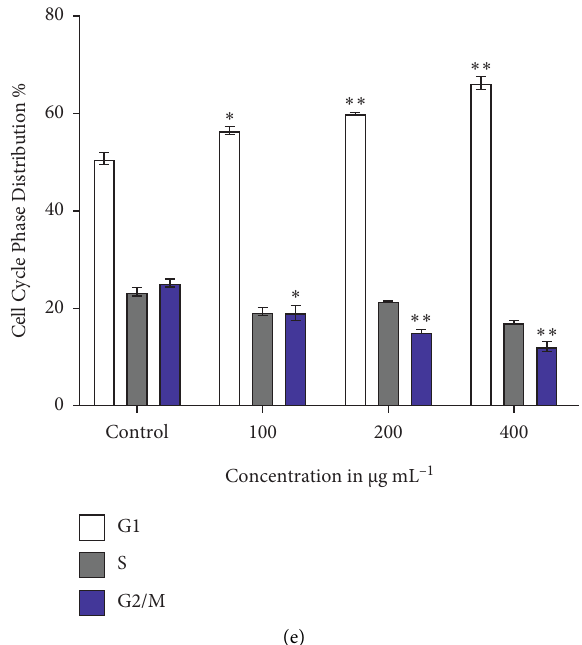
Figure 15: Flow cytometry assessment of cell cycle distribution (G1, (S), and G2/M) of A549cells treated with different concentrations of the NPs synthesized with the magnetic field at 60mJ/cm 2 for 24 hrs. (a) Negative control; (b–d) 100, 200, and 400 µ gmL − 1 , respectively; (e) Statistical analysis of cell cycle distribution. ∗ P ≤ 0.05; ∗∗ P ≤